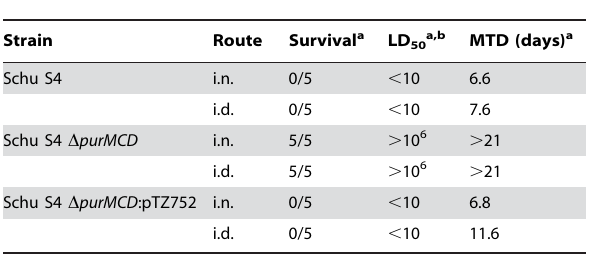
Table 1. Virulence of Schu S4 derivatives in BALB/c